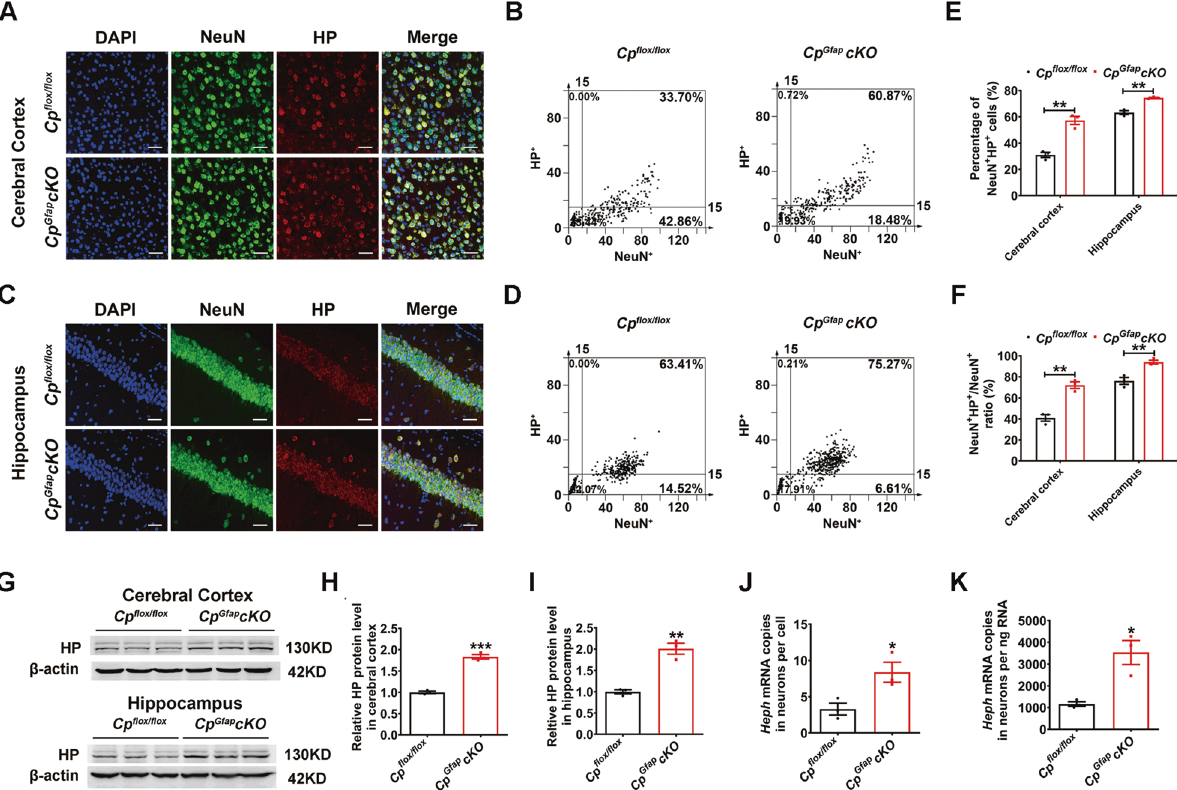
Fig. 5 The expression of hephaestin increased in neurons of Cp Gfap cKO mice. A - F Double immuno fl uorescence labeling of HP and NeuN in the cerebral cortex ( A ) and hippocampus ( C ) in Cp fl ox/ fl ox and Cp Gfap cKO mice. The intensity of NeuN + and HP + cells in the cerebral cortex ( B ) and hippocampus ( D ) is shown in scatter diagrams. Quanti fi cation of the percentage of the NeuN + HP + cells ( E ) and the ratio of NeuN + HP + / NeuN + ( F ) are shown in the bar graphs. ( n = 3). DAPI was used for nuclear staining. Scale bar: 50 μ m. G-I: Western blot detection of HP levels in the cerebral cortex and hippocampus ( G ). Quanti fi cation of the amount of HP in the cerebral cortex ( H ) and hippocampus ( I ). ( n = 3). Neurons were isolated using a Neuron Isolation Kit and Heph mRNA levels were detected by qPCR, J and K show the quanti fi ed amounts of Heph mRNA per cell and per ng RNA, respectively. ( n = 3). All data are shown as the mean ± SEM; * p < 0.05; ** p < 0.01; *** p < 0.001 vs. Cp fl ox/ fl ox